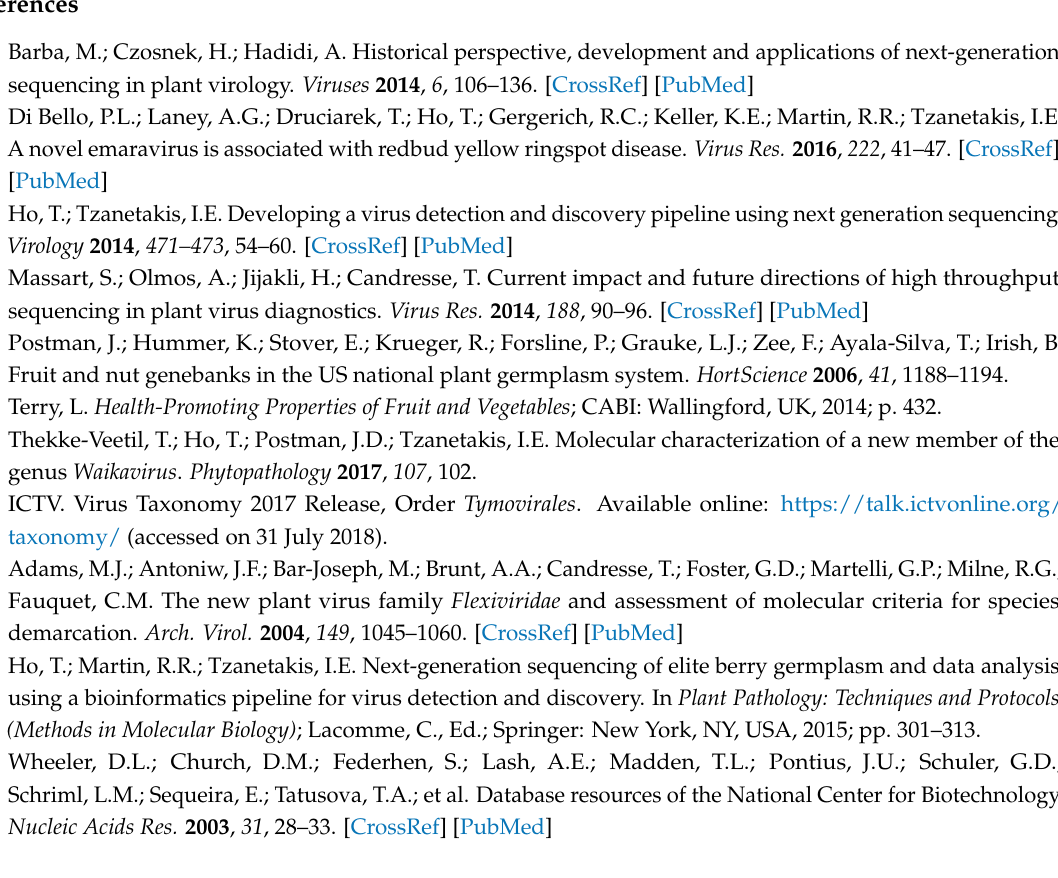
Figure S1: Predicted secondary structures (PSI-Pred; [14]) of the Ribes americanum virus A proteins. Table S1: Primers and PCR conditions used for the amplification of the Ribes americanum virus A